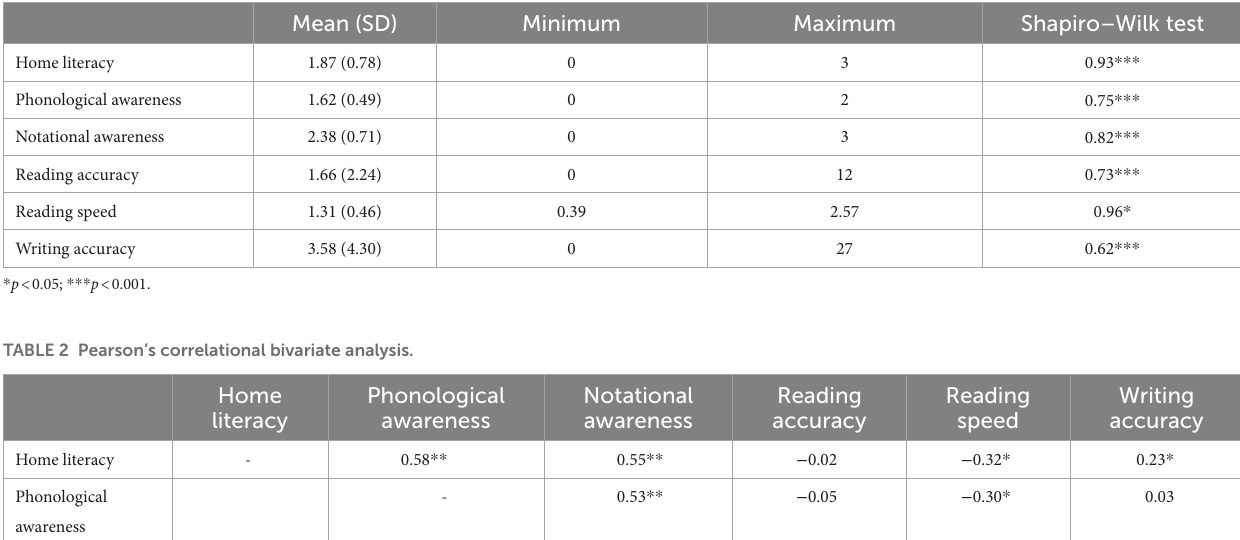
TABLE 1 Descriptive statistics and Shapiro–Wilk coefficients.